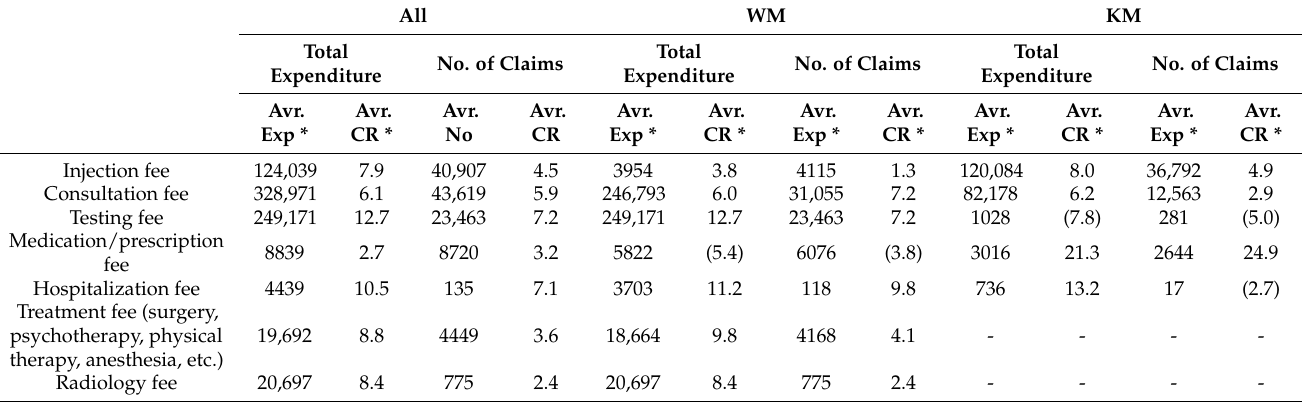
Table 3. Average total expenditure, the total number of cases, and average rate of change over nine years.